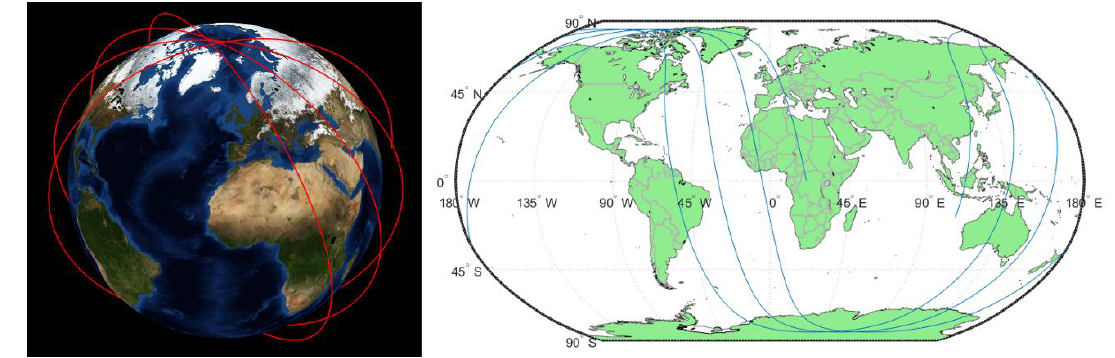
Figure 8. Orbits and tracks on ground of Metop − C satellite. 20 October 2021; starting time: 20:07:26 UTC.